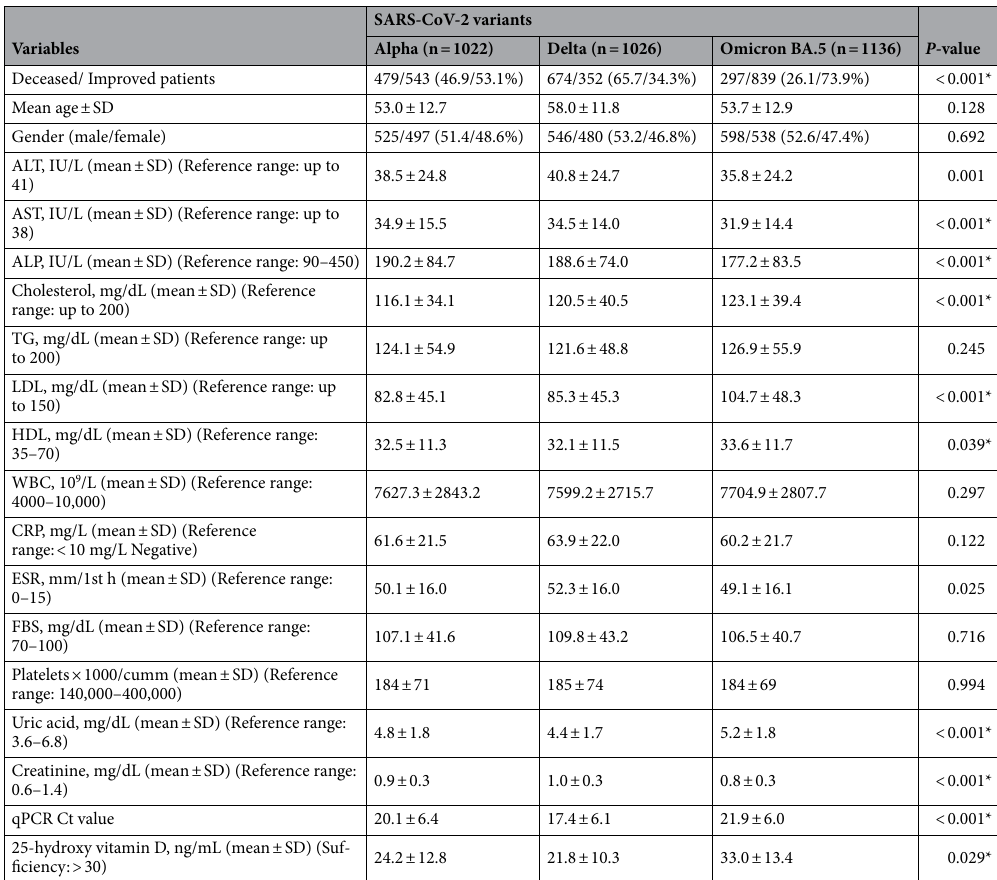
Table 1. Comparison of laboratory parameters between SARS-CoV-2 variants. ALT alanine aminotransferase, AST aspartate aminotransferase, ALP alkaline phosphatase, TG triglyceride, LDL low density lipoprotein, HDL high density lipoprotein, WBC white blood cells, CRP C-reactive protein, ESR erythrocyte sedimentation rate, FBS fasting blood glucose, SD standard deviation, SARS-CoV-2 Severe Acute Respiratory Syndrome Coronavirus 2. *Statistically significant (<